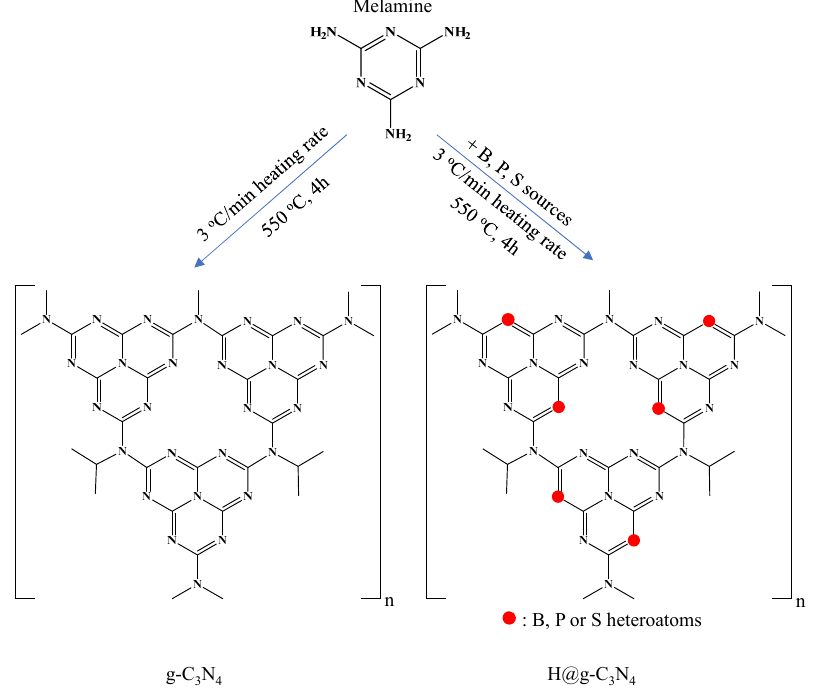
Figure 1. The schematic presentation of g-C 3 N 4 and H@g-C 3 N 4 structure. Heteroatom-doping is supposed not to disturb the staking and in-layer structure of the networks and is reported as the heteroatoms participate in cyclic basic structural units of g-C 3 N 4 structures [12,14–16]. It was also demonstrated as the heteroatoms B, P, and S were randomly distributed in